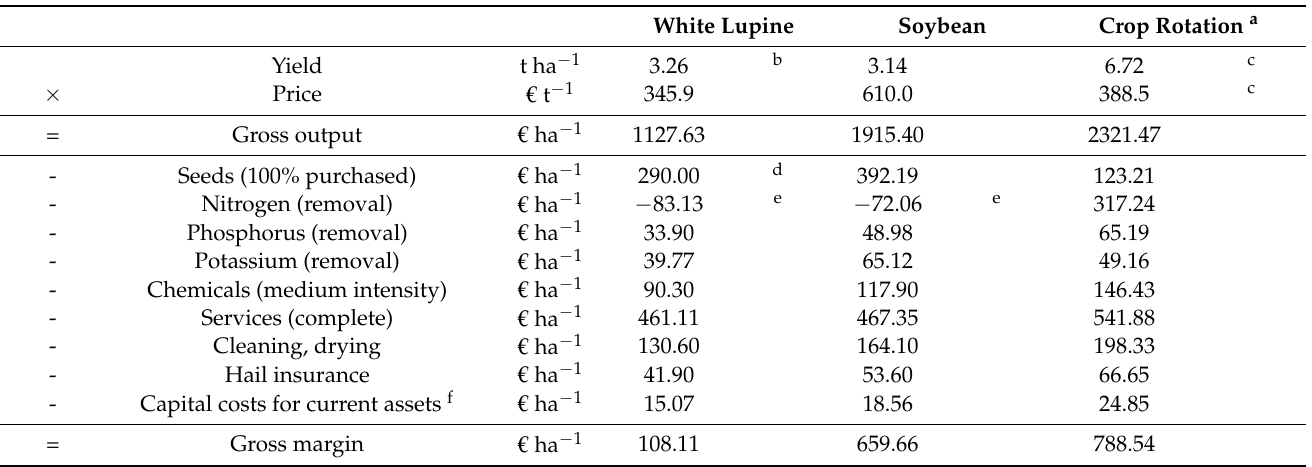
Table 3. Comparison of selected gross